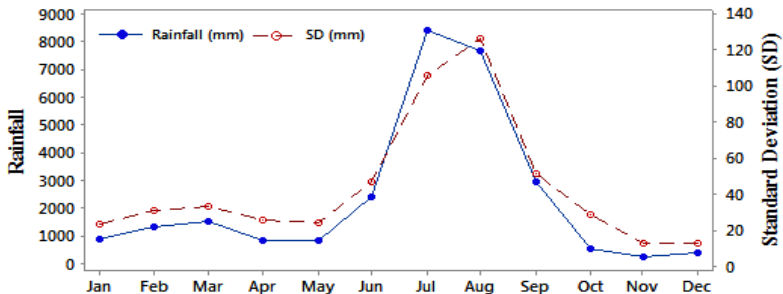
Figure 5. Time series of the standard deviation of total rainfall of Lahore district within 1970–2012.